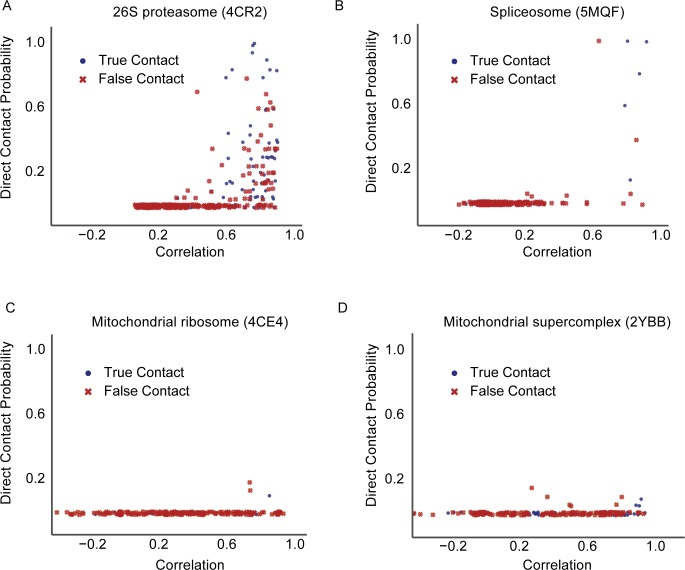
Relationship between direct contact probability and correlation for four example complexes with known structure.A. Direct contact predictions for the well-observed proteasome (pdbid: 4CR2) show good discrimination between true (blue circle) and false positives (red x) compared to that of correlation. B. Direct contact predictions for the moderately observed spliceosome complex (pdbid: 5MQF) shows good discrimination between true and false positives but with a limited number of total predictions. C. The direct contact method does not make high confident predictions for the mitochondrial ribosome (pdbid: 4CE4) due to its limited sampling while correlation makes many high ranking false positive predictions. D. Similar to C, the direct contact method does not make predictions for the mitochondrial super-complex (pdbid: 2YBB) due to its limited sampling while correlation makes several high confident true positive predictions.